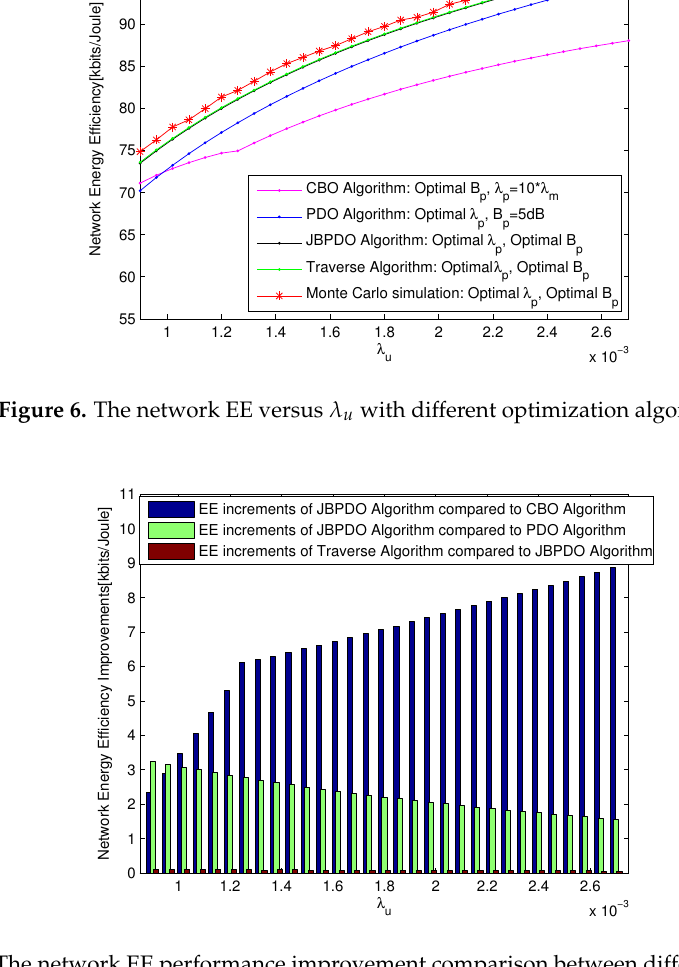
Figure 7. The network EE performance improvement comparison between different